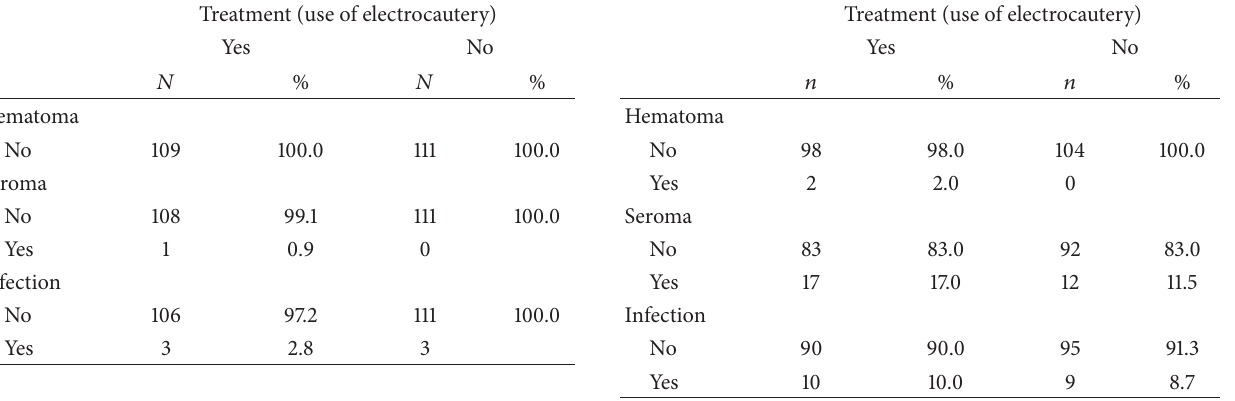
Table 2: Surgical scar complications on day 3 following C-section with and without the use of electrocautery.